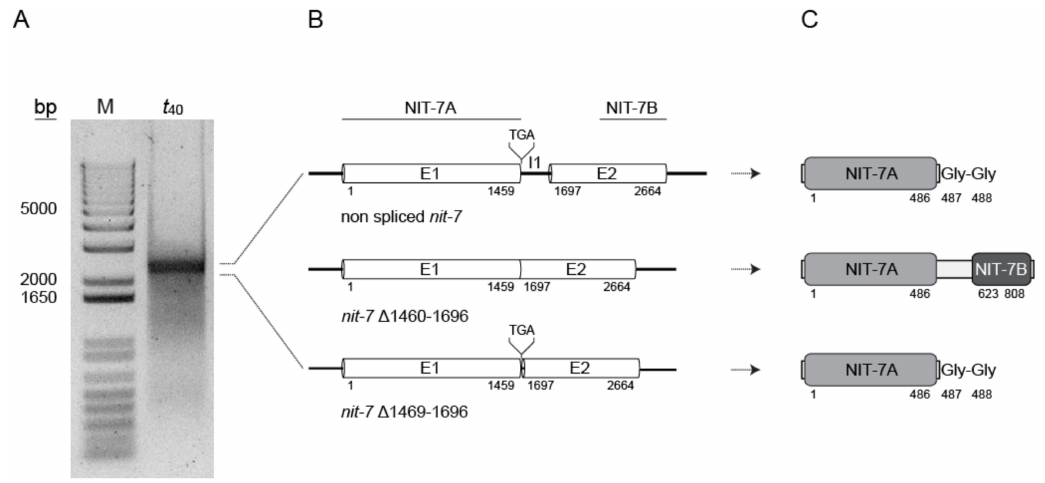
Figure 4. Identification of the novel nit-7 splice variant nit-7 ∆ 1469–1696. ( A ) Results from 5 (cid:48) RACE (5 (cid:48) rapid amplification of cDNA ends). ( B ) Schematic representation of the nit-7 exon (E) / intron (I) structure of non-spliced nit-7 , splice variants nit-7 ∆ 1460–1696 and nit-7 ∆ 1469–1696, respectively. Numbers below indicate the nucleotide position of the exon / intron borders. When existent in the respective nit-7 mRNA, the stop codon within intron 1 is indicated above. ( C ) Schematic representation of the encoded NIT-7 domains. The first and last amino acids of NIT-7A and NIT-7B are given below. The functional relevant double glycine motif encoded by I1 and the linker region encoded by exon 2 (white bar) are indicated. Numbers refer to the amino acid position within